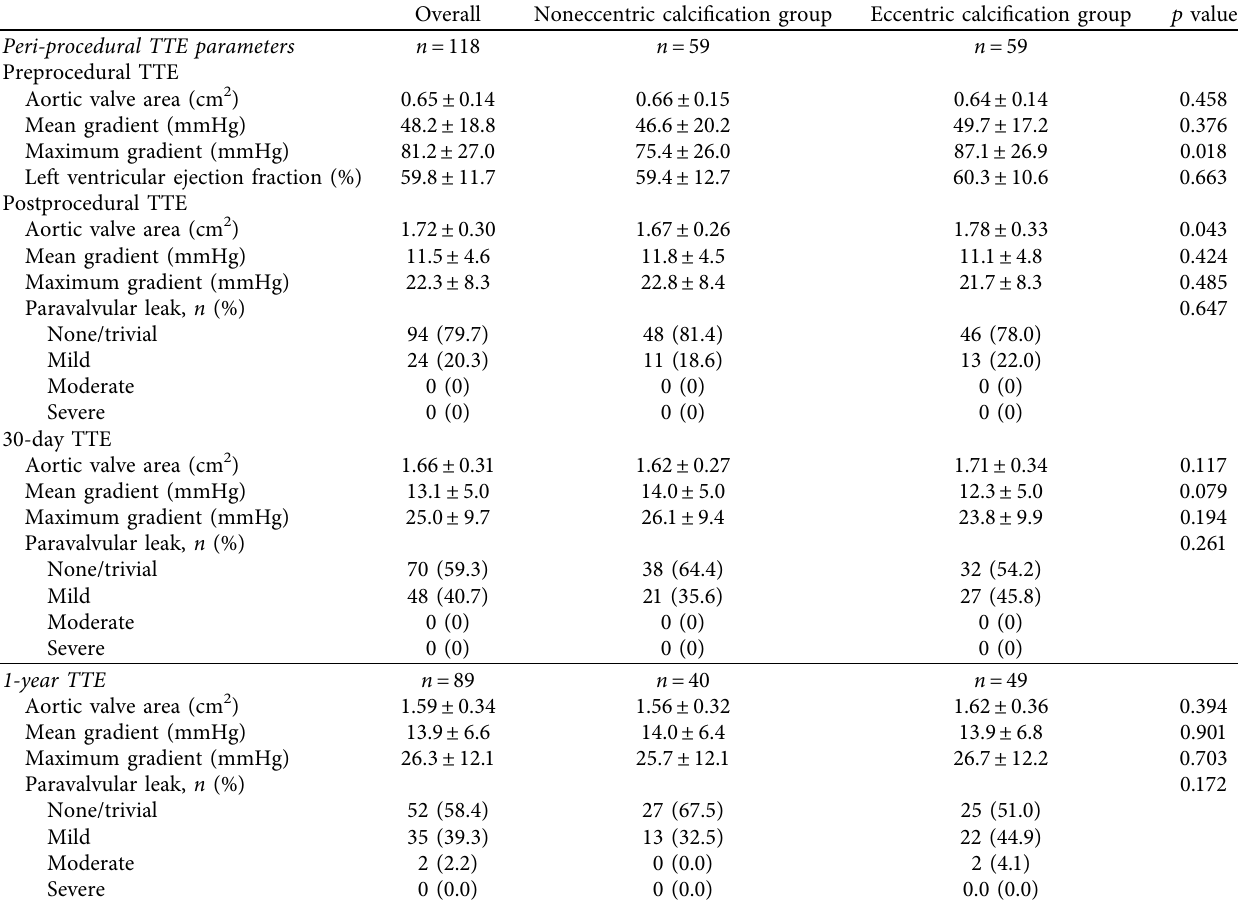
Table 4: Transthoracic echocardiogram